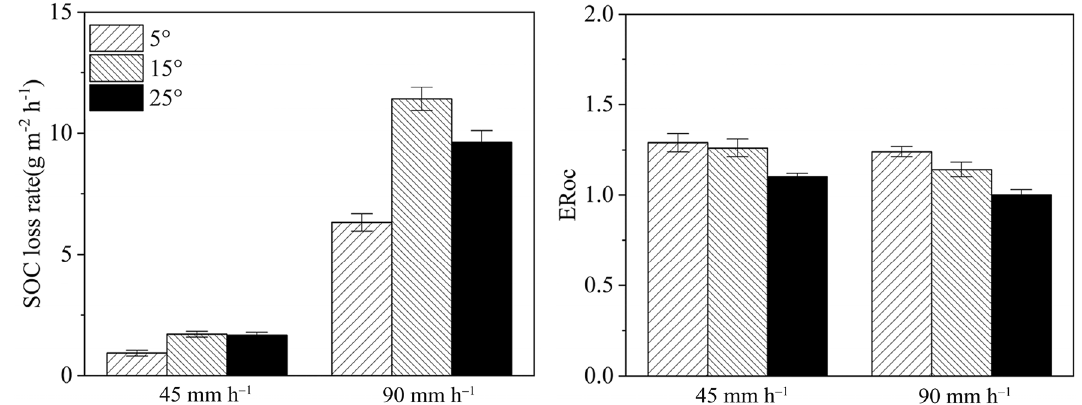
Fig. 4 SOC loss rate and ERoc for black soil under different rainfall intensity and